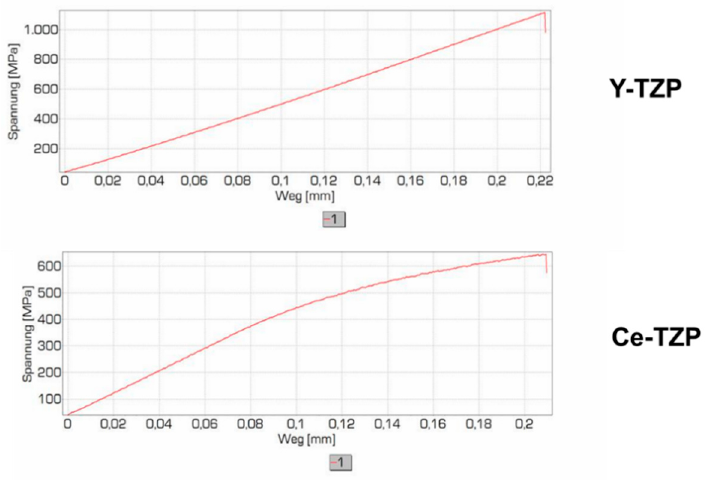
Figure 35. Stress-strain behaviour of Y-TZP and Ce-TZP.